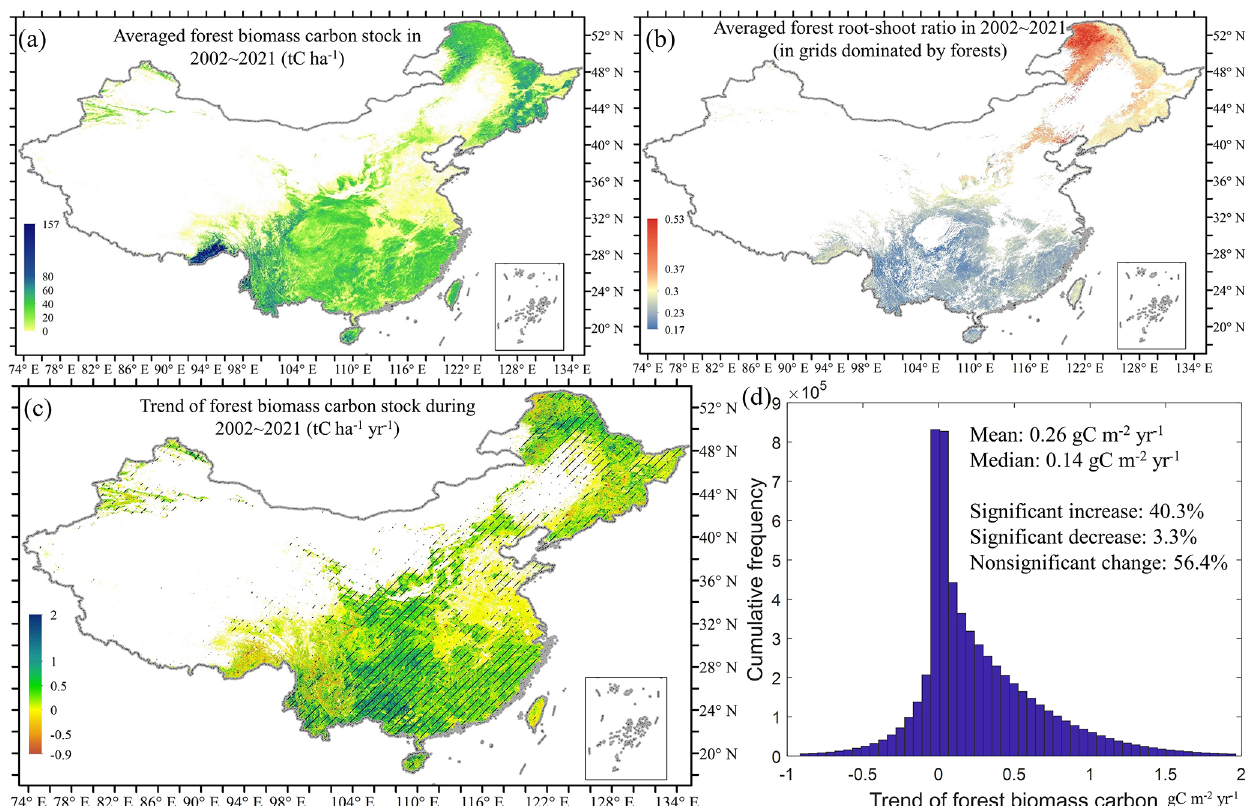
Figure 6. Maps of forest biomass carbon pool, allocation and trend in China during 2002–2021. (a) Spatial pattern of the forest biomass carbon pool in China. (b) RSR of all forestland pixels. (c) Map of the forest biomass carbon stock trend from 2002 to 2021, with shaded areas representing statistically significant trends at the 95% confidence level. (d) histogram and basic statistics of all forest biomass carbon stock